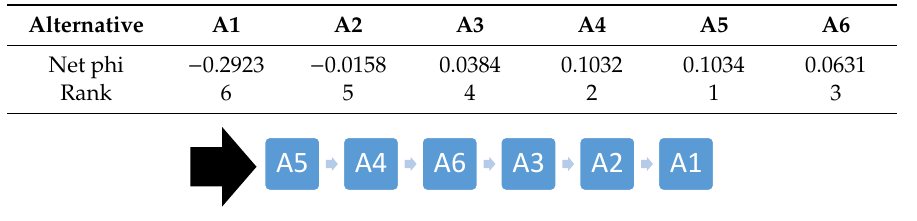
Table 16. Change 2 Table 17. Change 2 results. Table 16. Change 2 results.